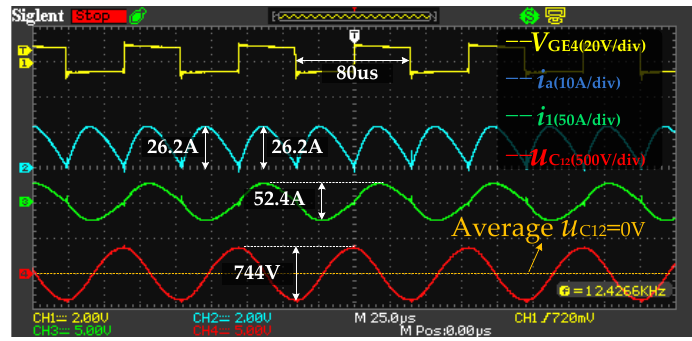
Figure 14. Experimental waveforms of FRC IPT system.